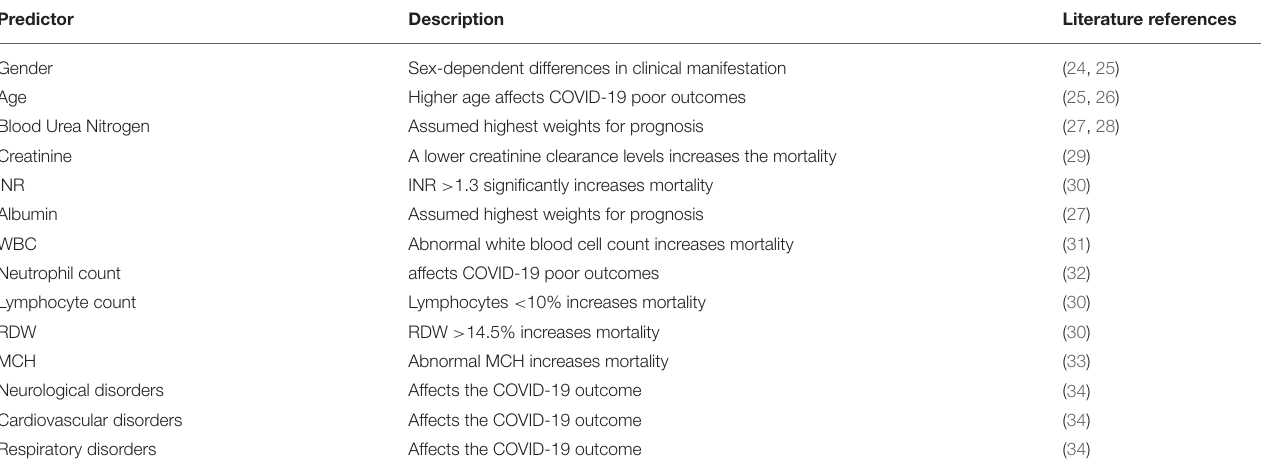
TABLE 3 | Predictors with the highest predictive value, selected in this study, along with studies referring to